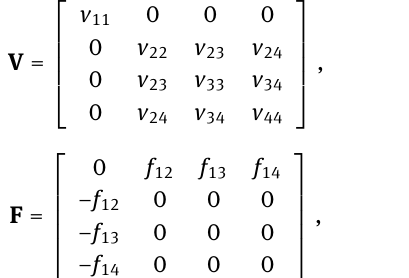
Figure 1: A central interfacial crack in a MEE